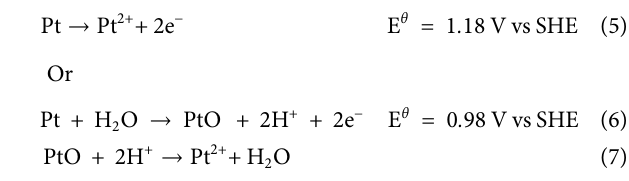
Frontiers in Chemistry |